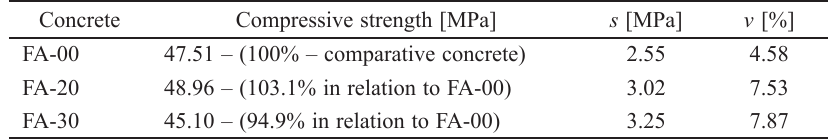
Table 2. Compressive strength of concretes